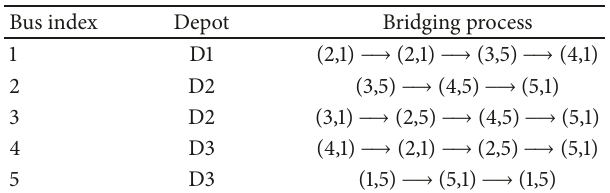
Table 1: Optimization results in illustrative